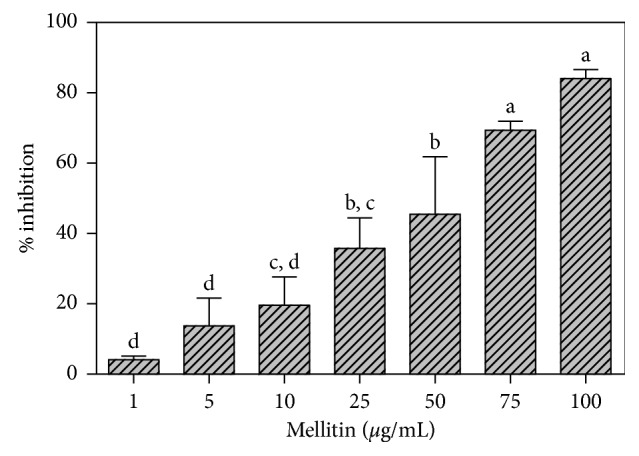
Effect of melittin on the inhibition of polymicrobial biofilm; data with different letters (a–d) are significantly different (Tukey's, p < 0.05).